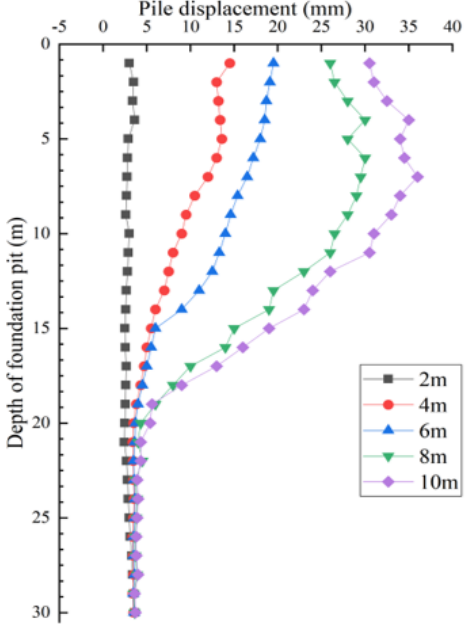
Figure 9. Horizontal displacement of front row inclined pile.